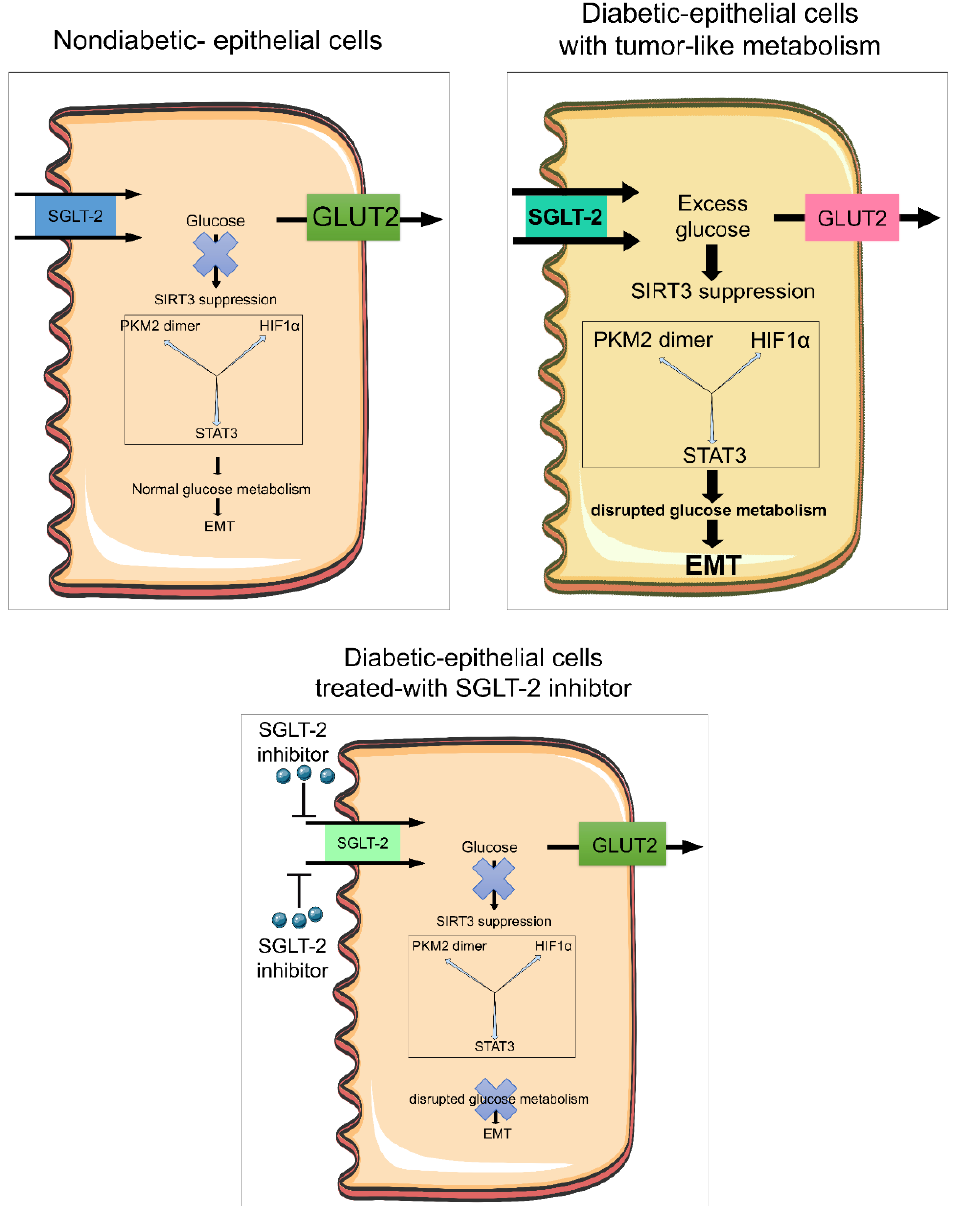
Figure 2. Pathological significance of urinary glucose in the disruption of glucose metabolism. SGLT-2 is highly expressed in diabetic epithelial cells. The function of SGLT-2 is to absorb urinary glucose which can then be reabsorbed into the blood, however, in severe diabetes, this excess glucose accumulates in the cytosol, activates SIRT3-deficiency-associated induction of augmented glycolysis and suppresses fatty acid metabolism. Accumulation of PKM2, HIF1 α , and STAT3 phosphorylation play a key role in the disruption of central metabolism, a phenotype that is similar to the Warburg e ff ect in tumor cells. This disruption in central metabolism leads to epithelial cell injury and promotes EMT processes. SGLT-2 inhibition abolishes these e ff